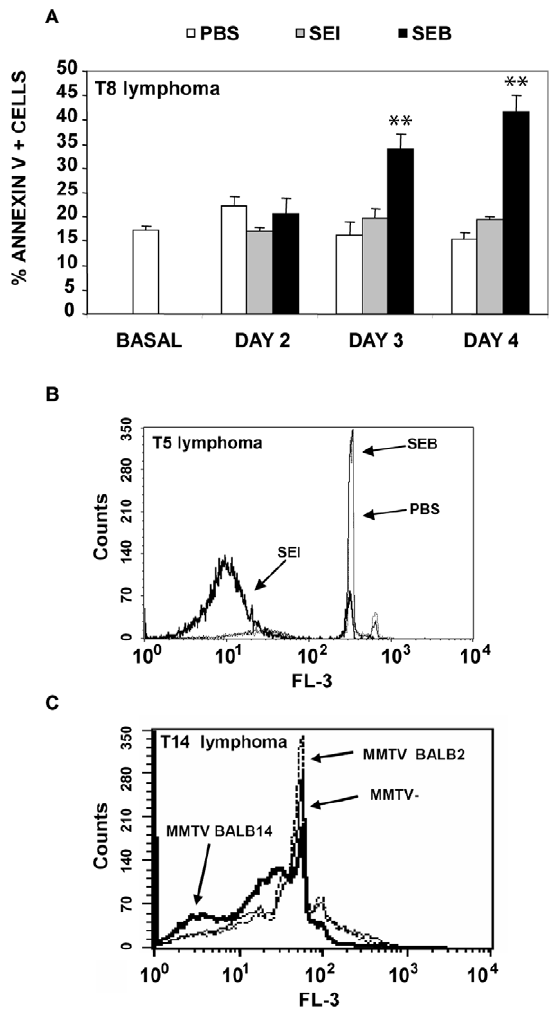
Figure 3. Sags increase apoptosis of cognate lymphoma T cells invitro . (A and B) T8 or T5 lymphoma cells (2.5 6 10 5 ) were co-cultured with 0.7 6 10 5 intraperitoneal macrophages in the presence of 10 m g/ml of the indicated bacterial Sags or PBS. (A) Percentage of apoptosis in T8 cells at different days as assessed by FACS using Annexin V-7AAD. Data are expressed as the mean 6 SD, n=4, ** p , 0.01. (B) Representative overlayed histograms of PI showing the DNA content in T5 cells cultured with 10 m g/ml of SEB, SEI or PBS during 3 days. (C) T14 lymphoma cells (2.5 6 10 5 ) were co-cultured with 0.7 6 10 5 mytomicin-C pretreated splenocytes from (MMTV-) non-infected AKR/J mice, MMTV BALB2- or MMTV BALB14-infected AKR/J mice. The Figure depicts representative overlayed histograms of PI showing the DNA content in T14 cells at day 3 of culture. All the experiments were performed five times with similar